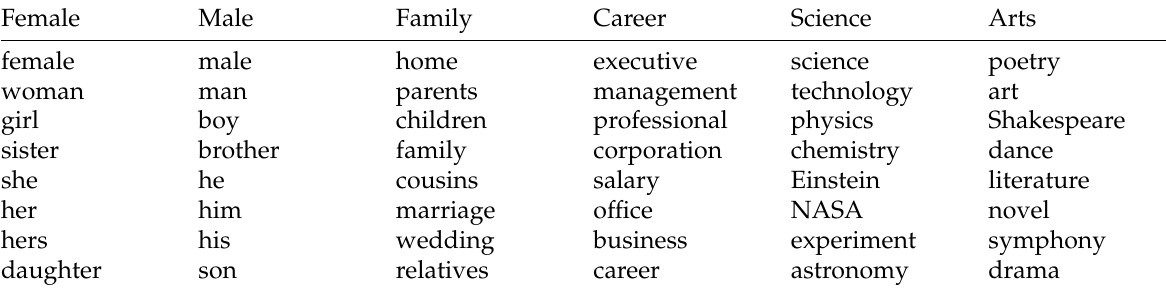
Table 1: List of Implicit Association Test words Female Male female